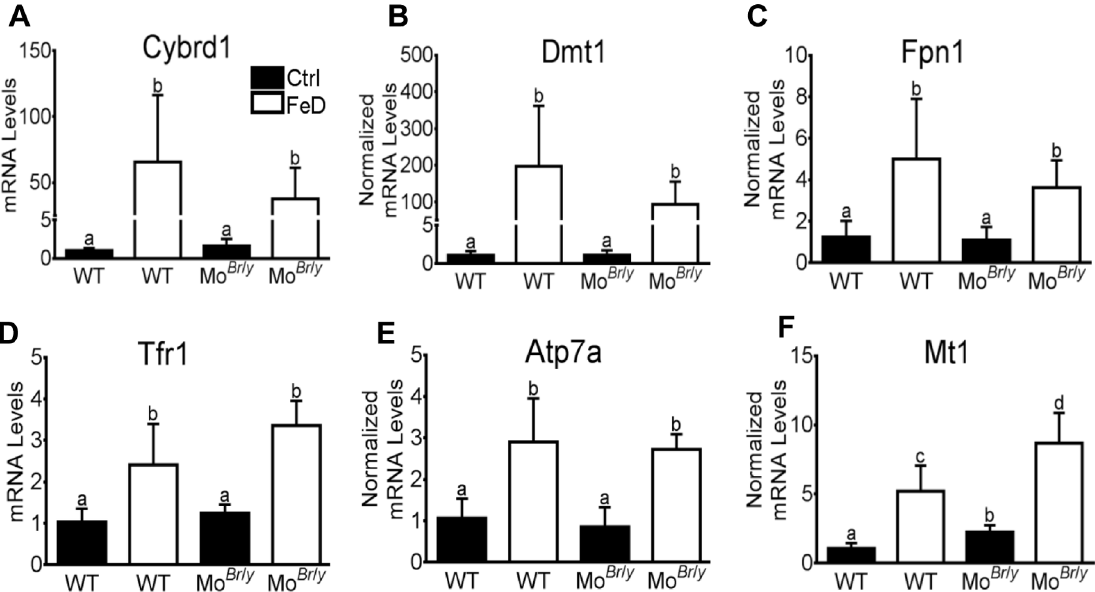
Figure 3. Intestinal qRT-PCR analysis of iron and copper homeostasis-related genes. Expression of key genes (indicated in each panel) was determined by standard methods, with each experimental gene being normalized to expression of mouse cyclophilin mRNA (which did not vary significantly). Filled bars represent data from mice fed the control diet and open bars represent data from mice consuming the low-iron diet. Genotype is indicated below each bar. a,b,c,d Statistically different from one another within each panel ( p , 0.05). n=4 for each genotype consuming the control diet and n=6 for each genotype fed the low-iron diet. WT, wild-type. Bars (A–F) depict mean 6 SD. doi:10.1371/journal.pone.0066010.g003 PLOS ONE |